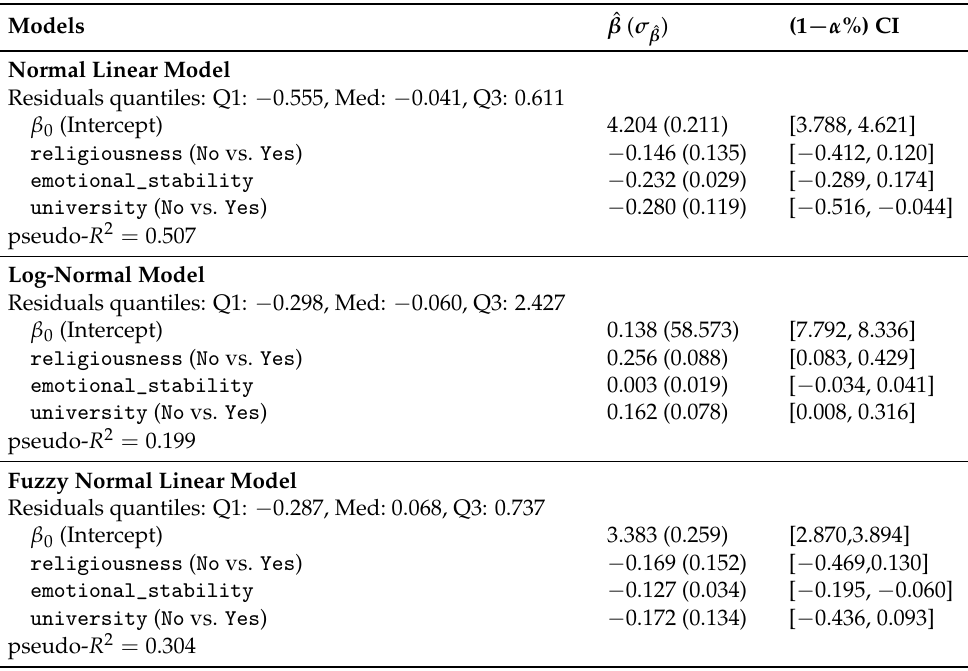
Table 1. Application: Estimates, standard errors, and CIs of the normal linear model on crisp ratings, log-normal linear model on response times, and the fuzzy normal linear model on the composite indicator depression . Note that the categorical variables have been codified with dummy